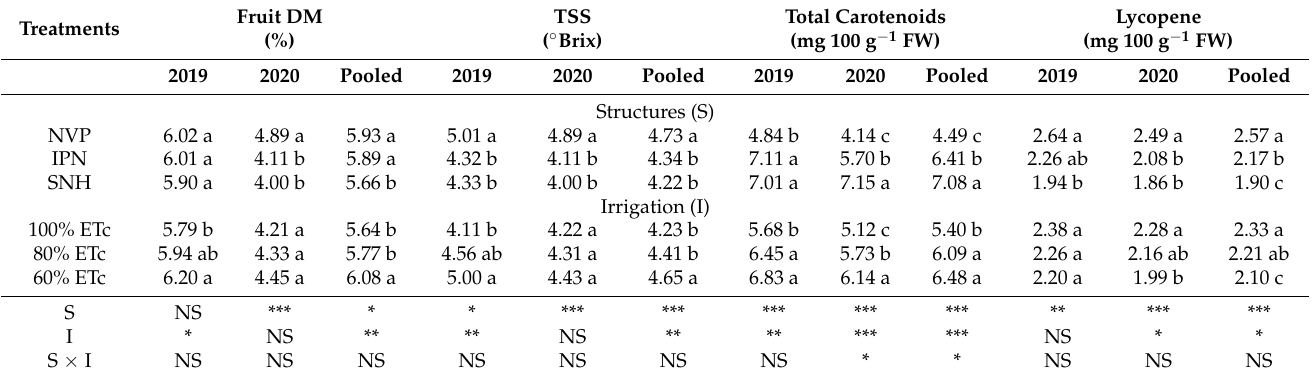
Mean values of three replicates followed by the same letter for each factor within each column are not significantly different according to DMRT p ≤ 0.05. NS, Non-significant; Significance *, **, *** at p ≤ 0.05, 0.01 and 0.001,